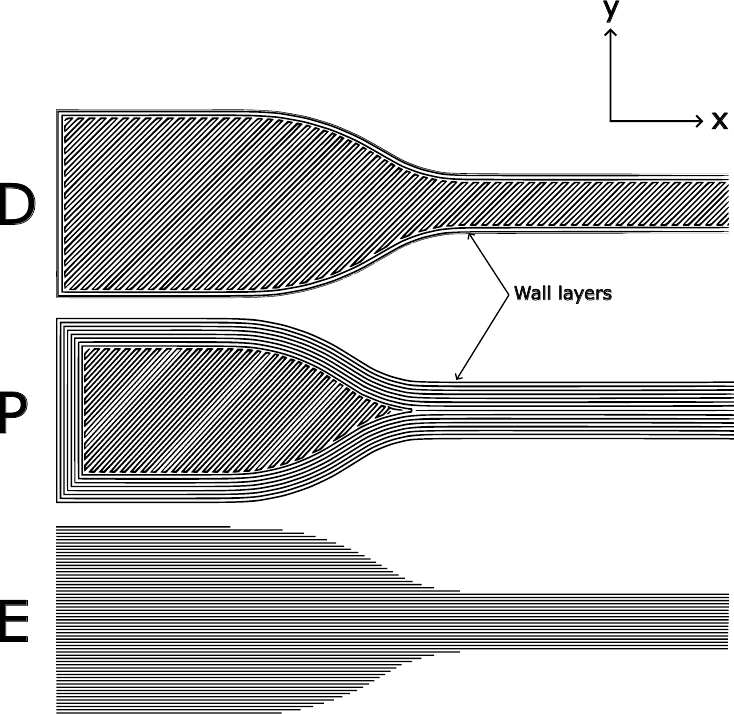
Figure 1. Infill of tensile specimens. D: default, P: parallel, E: on-edge. Increasing the number of wall layers for the parallel (P) specimens resulted in a discontinuity in the print path near the neck of the specimen. This was unavoidable due to limitations within the slicing; however, care was taken to ensure this discontinuity was as far from the gauge section as possible. To ensure printability, the on-edge (E) samples required a supporting structure under the raised gauge section. The supporting structure was automatically generated by Eiger and printed in the same material as the specimen. The support was removed after printing, leaving the underside of the specimen, particularly in the neck region, with some